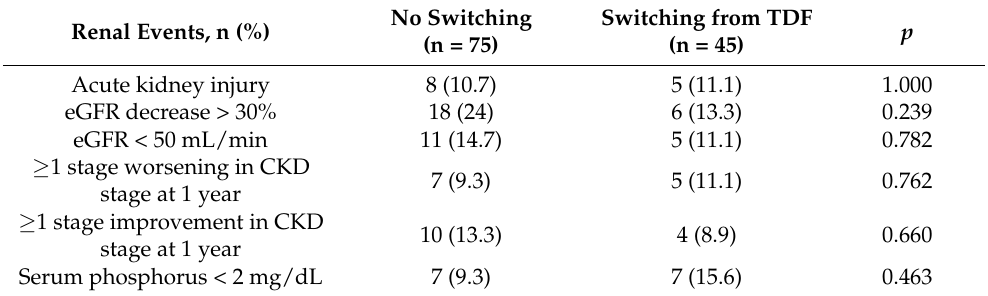
Table 4. Incidence of renal events at 1 year in 120 TAF-treated patients with follow-up of more than 1 year, with and without switching from